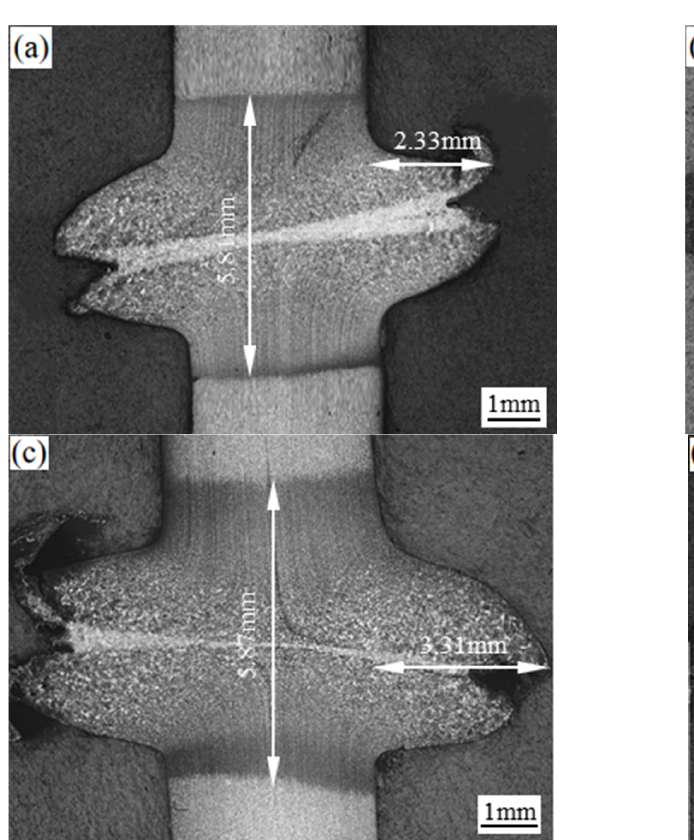
Figure 1. Defects in the welded joint of test steels. ( a ) Incomplete Fusion Defects caused by low current; ( b ) Melting defect caused by excessive current.